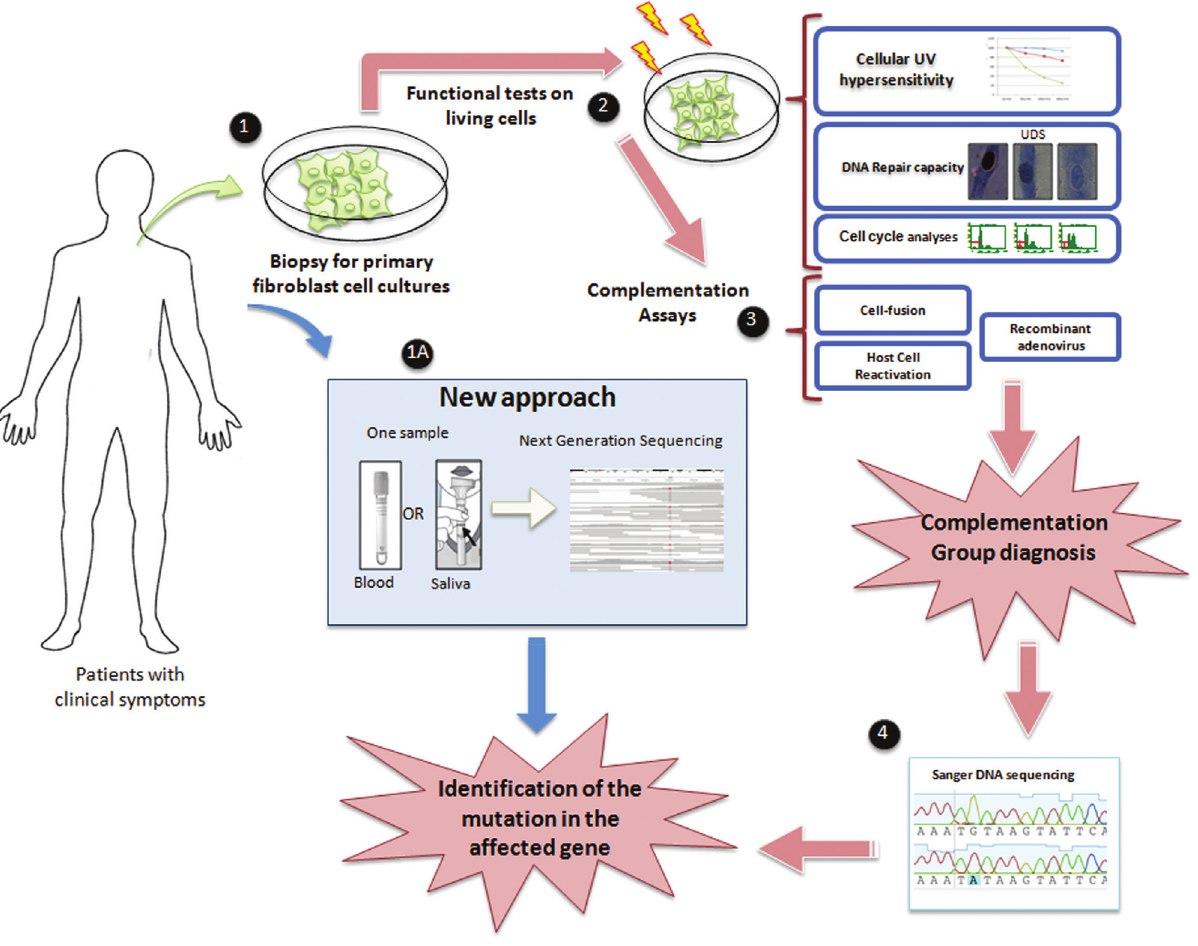
Figure5 -StrategiesformoleculardiagnosisofXPpatients.IdentificationofXPgenemutationbasedonaseriesofbiologicalandbiochemicalassaysus- ing primary cells obtained from patient skin biopsies. Although the information from these cells has always been rich, the direct sequencing of DNA re- pair genes using next generation sequencing techniques may facilitate the molecular diagnosis using blood or saliva